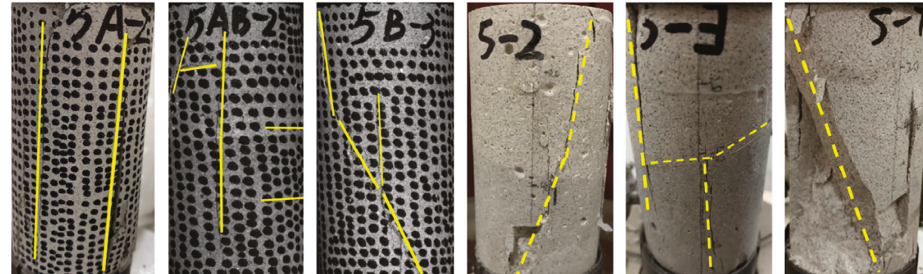
Figure 8: Deformation and failure modes of rock